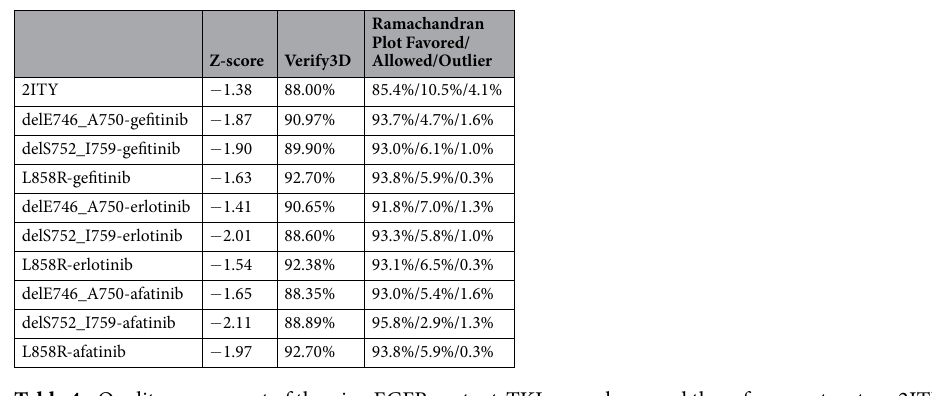
Table 4. Quality assessment of the nine EGFR mutant-TKIs complexes and the reference structure 2ITY. EGFR: epidermal growth factor receptor.